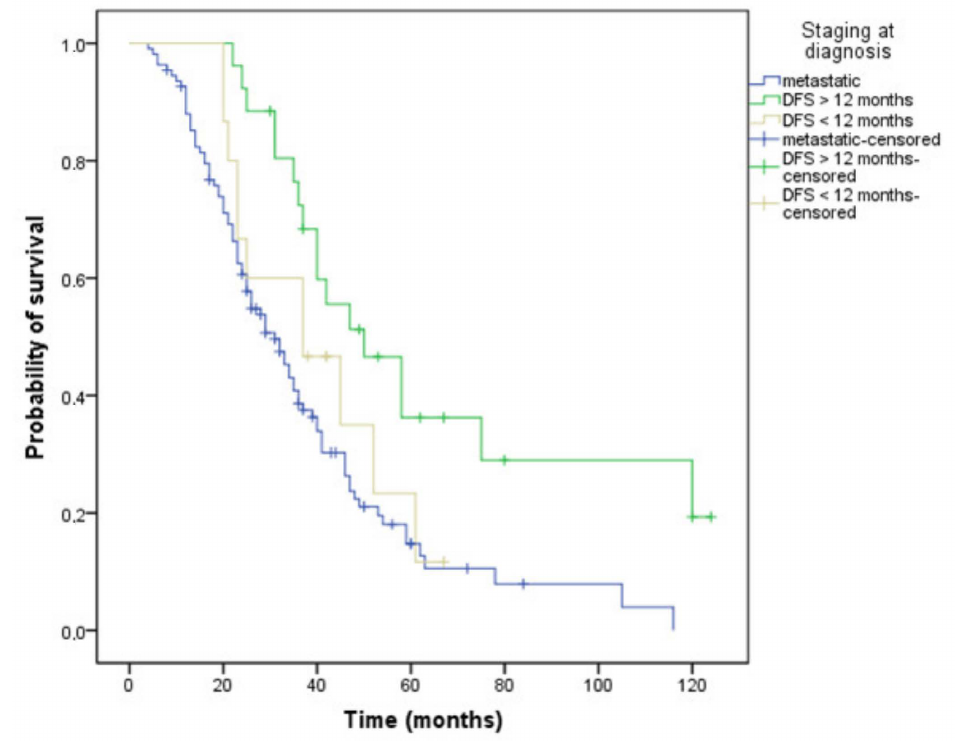
Figure 5. Kaplan–Meier curve of overall survival depending on the stage at diagnosis: metastatic or non-metastatic: DFS (disease-free survival) less or more than 12 months (OS, 31 versus 37 versus 50 months, p =